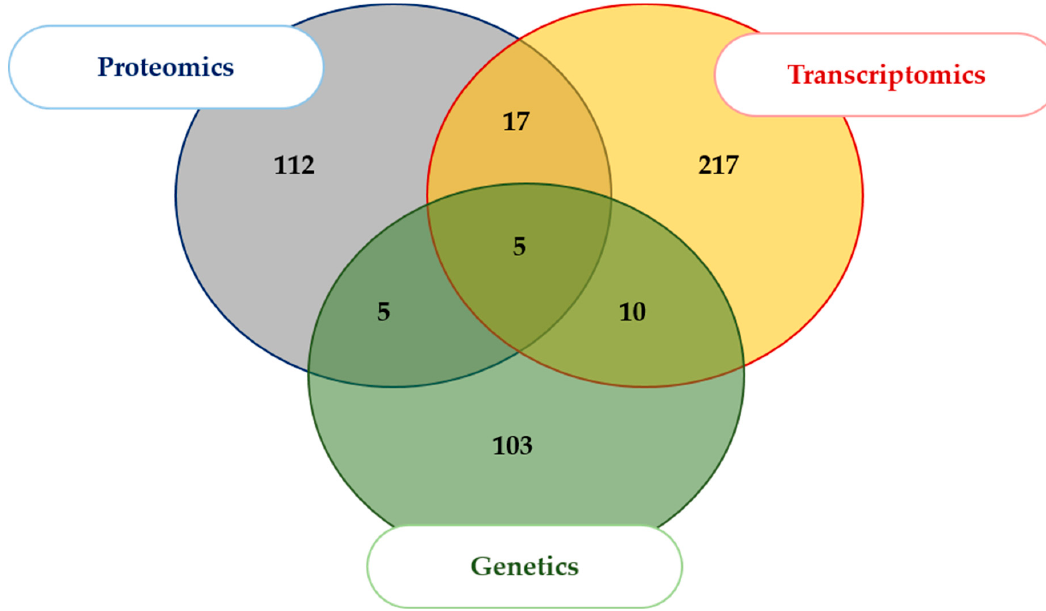
Figure 2. Origin of the omics data included in the study. The Venn diagram shows the intersects of the three omic datasets aggregated in the study. The aggregated dataset related to tenderness [64] was limited to the unique ID Gene Names.